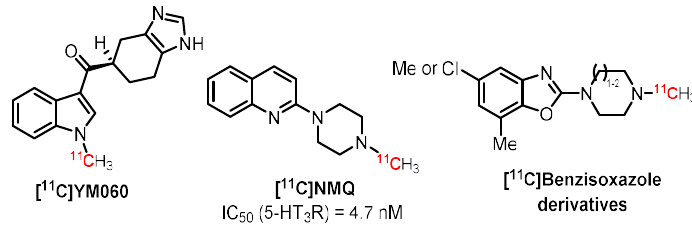
Figure 13. Miscellaneous derivatives as 5-HT 3 R radiotracers.